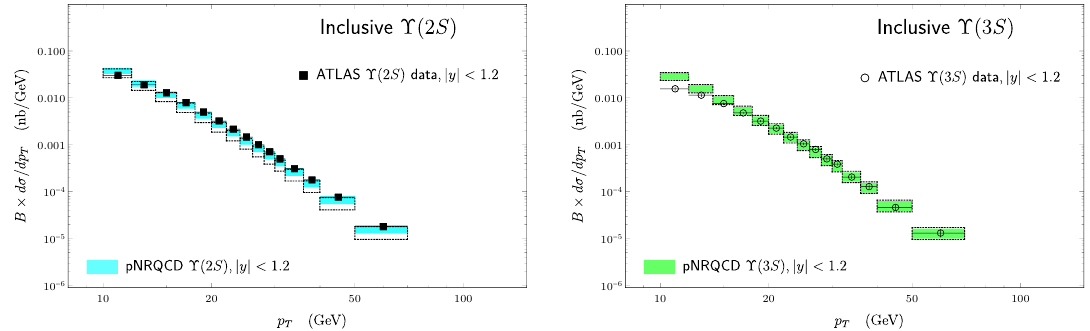
Figure 10 . Production cross section of inclusive Υ(2 S ) and Υ(3 S ) at the LHC center of mass √ energy s = 7 TeV compared to ATLAS data [71]; B is the dimuon branching fraction. Results from the LDMEs given in table 3 are shown as dotted outlined